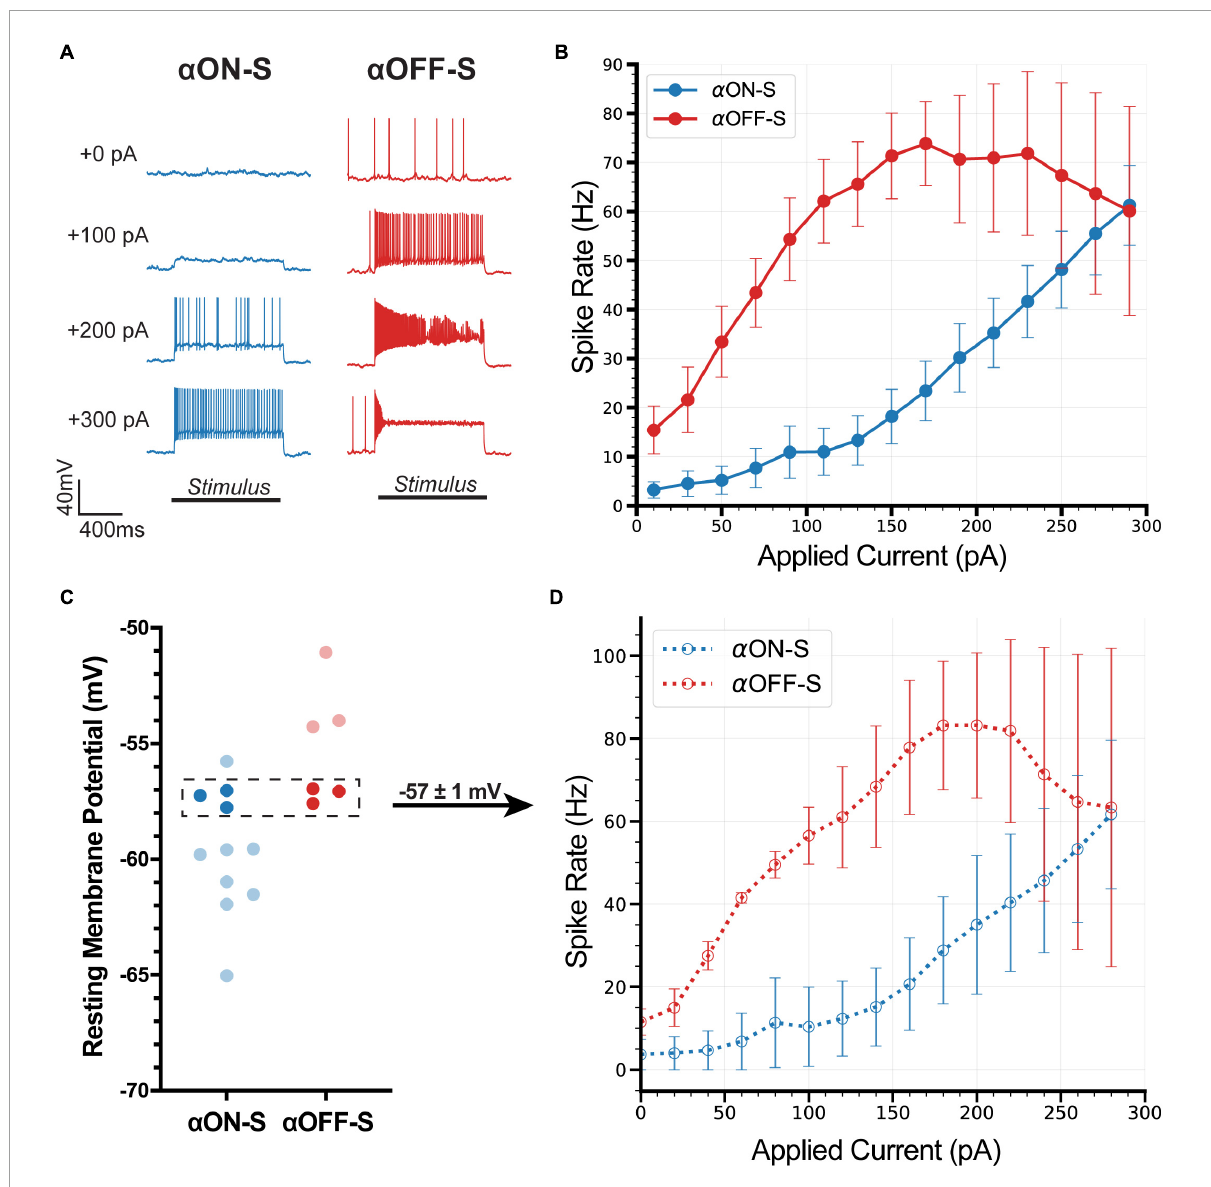
FIGURE2 Current-evoked spike dynamics demonstrate cell type-intrinsic differences. The voltage responses of retinal ganglion cells (RGCs) were recorded during 1 s pulses of depolarizing current (0–300 pA, 2 s inter-stimulus interval). (A) Representative current-clamp responses of alpha ON-sustained ( α ON-S) (left) and alpha OFF-sustained ( α OFF-S) (right) cells to 0, 100, 200, and 300 pA pulses. As magnitude of test current increases α OFF-S spike trains become more irregular and repetitive spiking is reduced. (B) α ON-S and α OFF-S cells respond differently to the same magnitude of stimulation. α OFF-S cells fire more rapidly but ultimately plateau and decrease in rate. A two-way ANOVA analyzing the effects of cell type and depolarizing current on spike rate demonstrates a significant interaction between cell type and current ( p < 0.0001). (C) To control for the influence of resting membrane potential (RMP) on current-evoked spiking we selected a subset of cells from both α ON-S ( n = 3) and α OFF-S ( n = 3) cells with overlapping RMPs (–57 ± 1 mV) for analysis. (D) This subset of α ON-S and α OFF-S cells still respond differently to the same magnitude of stimulation, closely resembling the pattern of the full sample (B) . Two-way ANOVAs indicate that there is no significant difference between the current-spiking relationship for the subset vs. full sample for either α ON-S ( p = 0.9317) or α OFF-S ( p = 0.9618). Error bars: ± standard error of the mean.